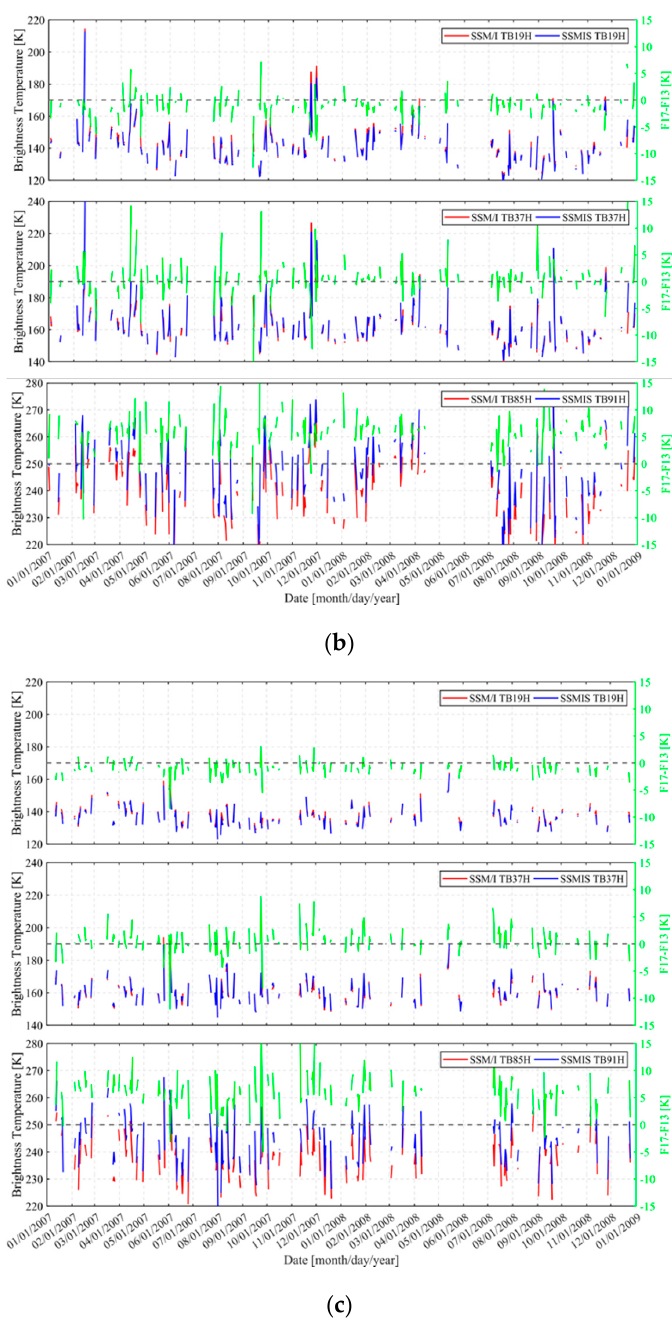
Figure 4. Time series of brightness temperature comparison between SSM/I and SSMIS in ( a ) NE; ( b ) XJ; ( c ) QTP. Red and blue lines represent satellite brightness temperature from SSM/I and SSMIS, respectively. Green lines denote brightness temperature difference between SSM/I and SSMIS, marked as “F17 ‒ F13”. The black dotted line displays no difference between SSM/S and SSMIS.